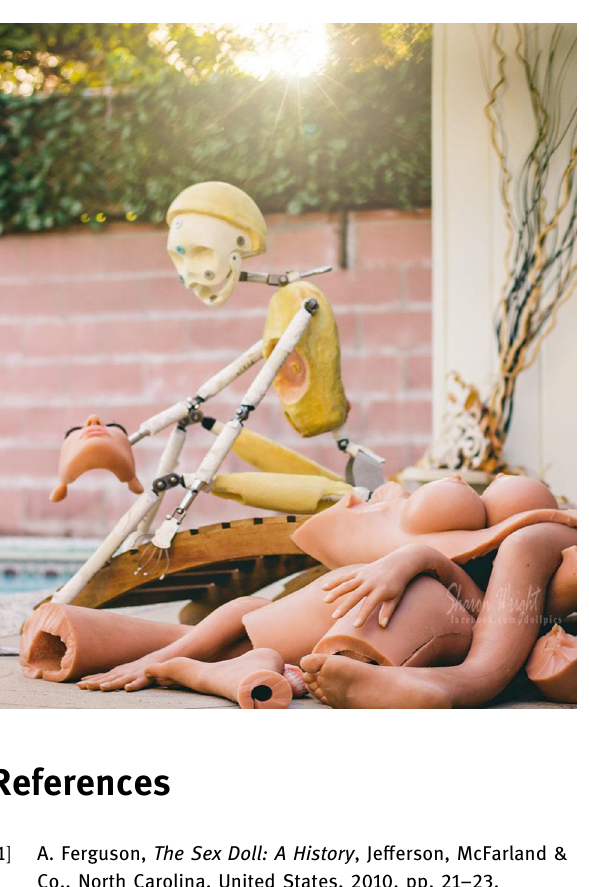
4. Doll photography by Sharon Marie Wright, as it appears on the Campaign Against Sex Robots website [ 60 ]